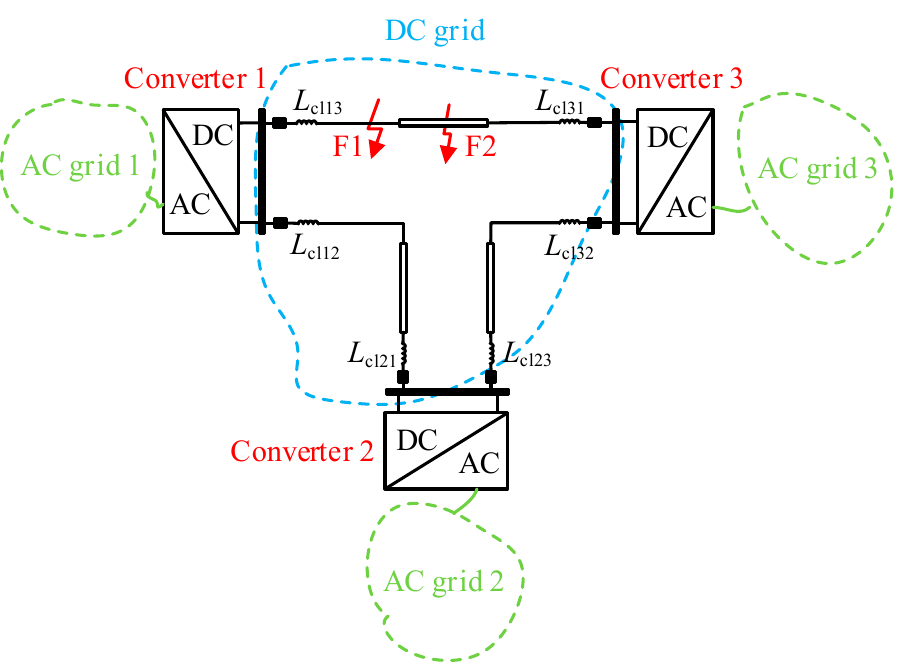
Figure 14. Simulation model of multi-terminal ring AC/DC hybrid distribution network.